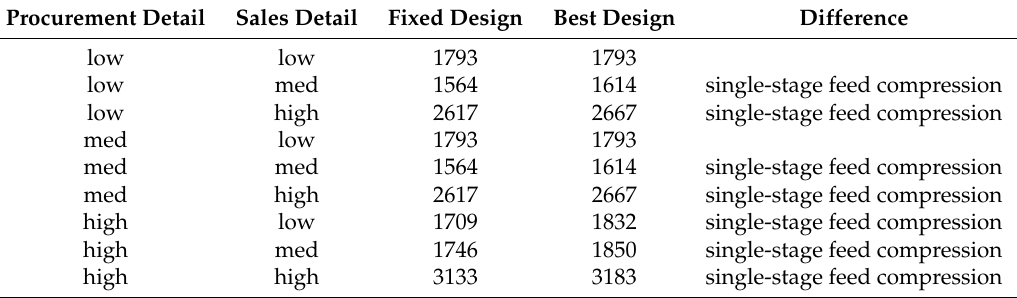
Figure 4. Solution flowsheet for Problem (P2), using two-stage feed compression, the cheap reactor, and single-stage recycle compression. At low procurement modeling detail, no feed selection decisions are made. Table 1. Profit (1000 USD) at the fixed production section design of two-stage feed compression, the cheap reactor, and single-stage recycle compression compared to the profit achievable when the design is allowed to